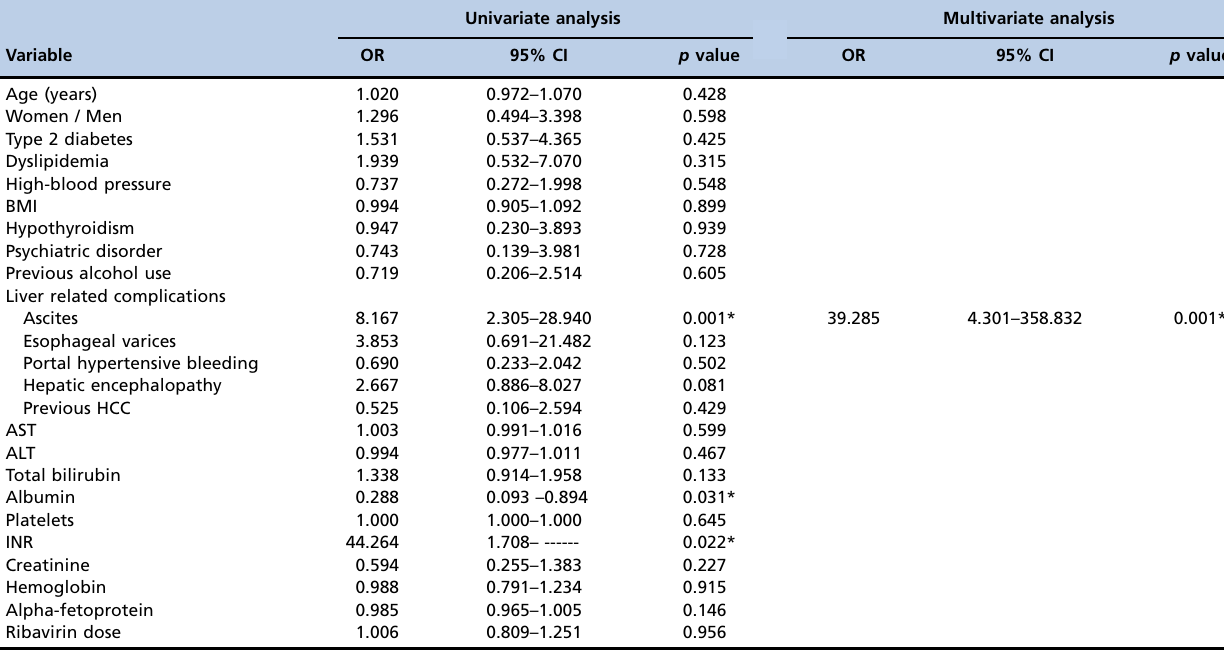
Table 6 - Factors associated with absence of Child-Pugh score improvement with